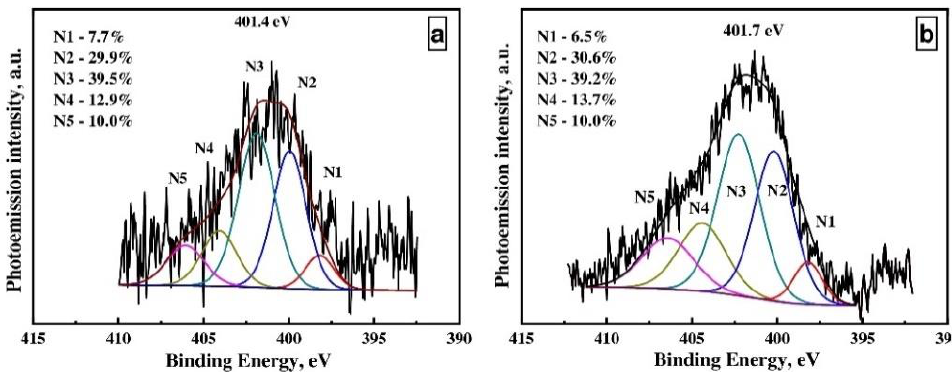
Figure 3. N1s PE spectra of N-CNT ( a ) and N + -CNT ( b ).